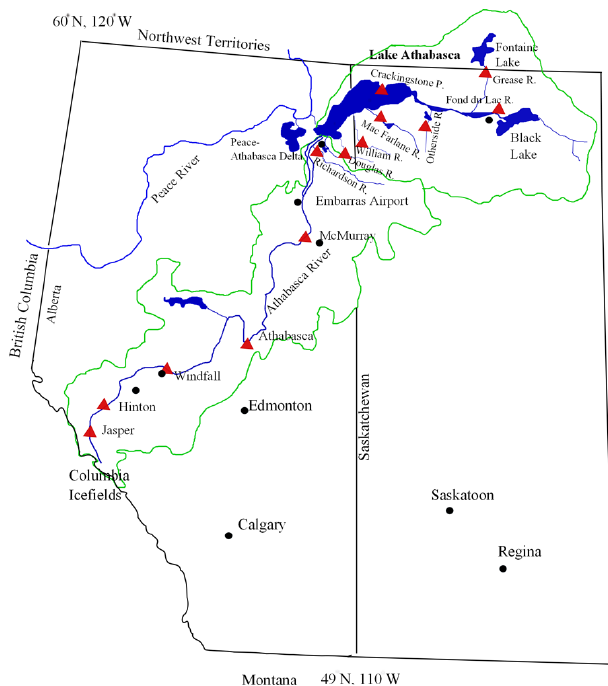
Fig. 1. Map of the Athabasca and Fond du Lac River basins and location of monitoring stations (red triangles) in the Lake Athabasca